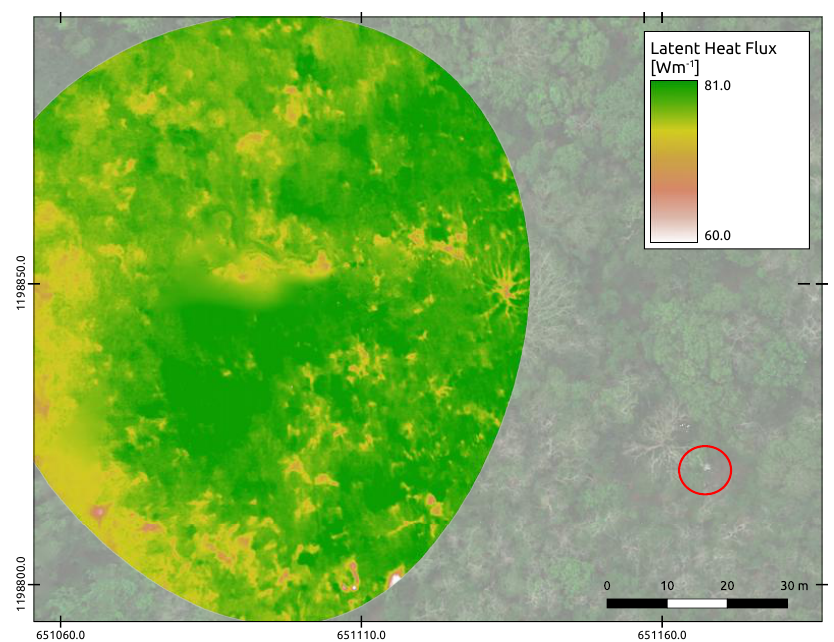
Figure 8. Modeled latent heat flux cropped for the 10th and 20th percentiles of the EC system footprint representing 63% of the flux contribution. Red circle indicates the position of the EC